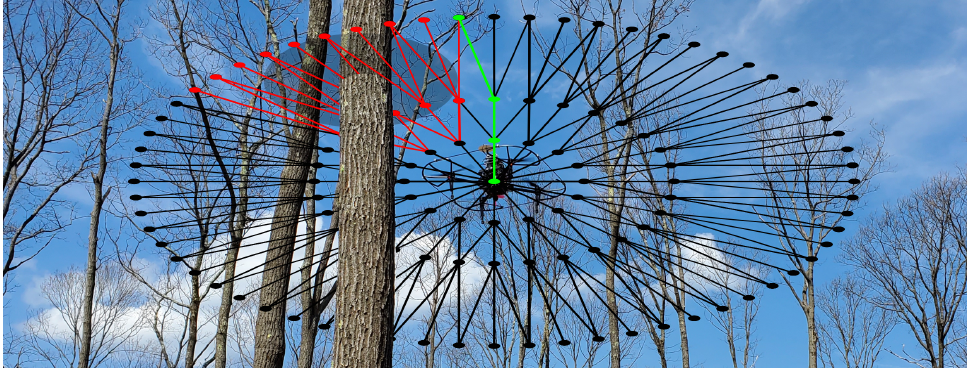
Figure 1. Illustration of the proposed methodology. A lattice in the sensor space encodes, in a search tree, the set of paths that the robot (i.e., drone) can take locally. The optimal path (green edges) is computed in real time by pruning the edges of the tree that are in collision (red edges) and minimizing a path cost functional on the remaining